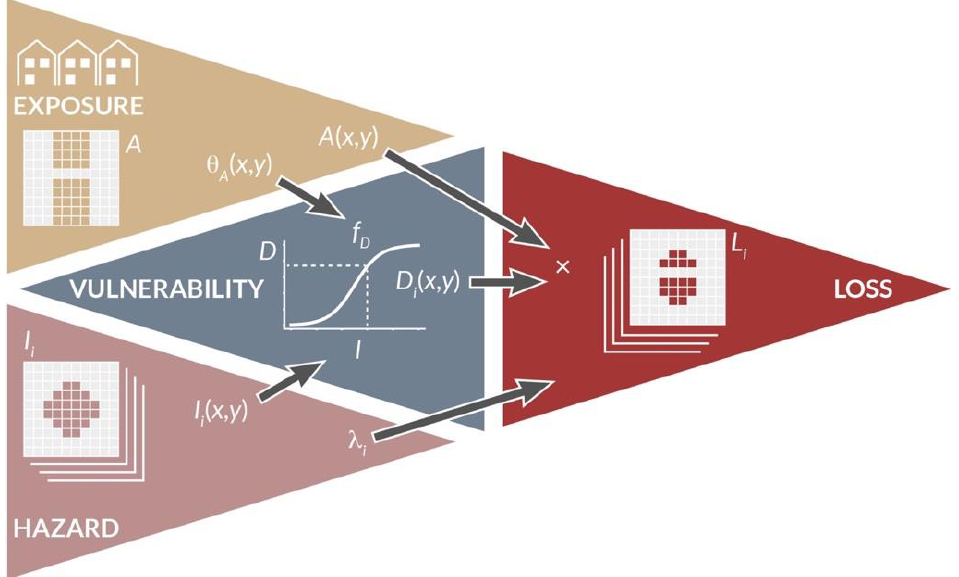
Figure 1. The CAT modeling framework. The binary grids represent the different spatial footprints for the exposed assets and for the stochastic events 𝑖 . See text for details and notation.